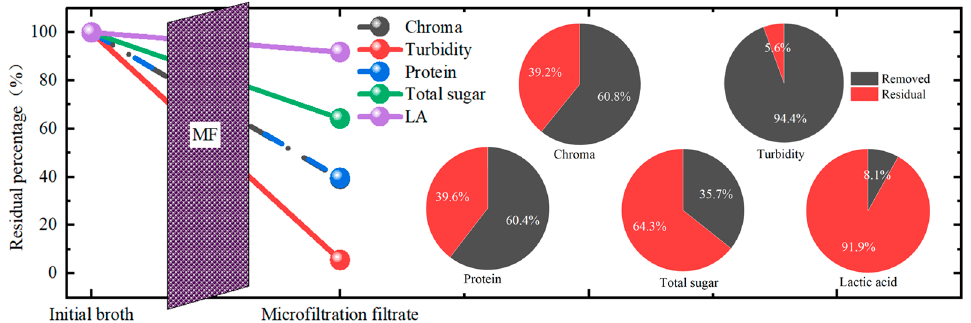
Figure 7. The whole removal performance of the microfiltration membrane separation and the removal percentage of each component.